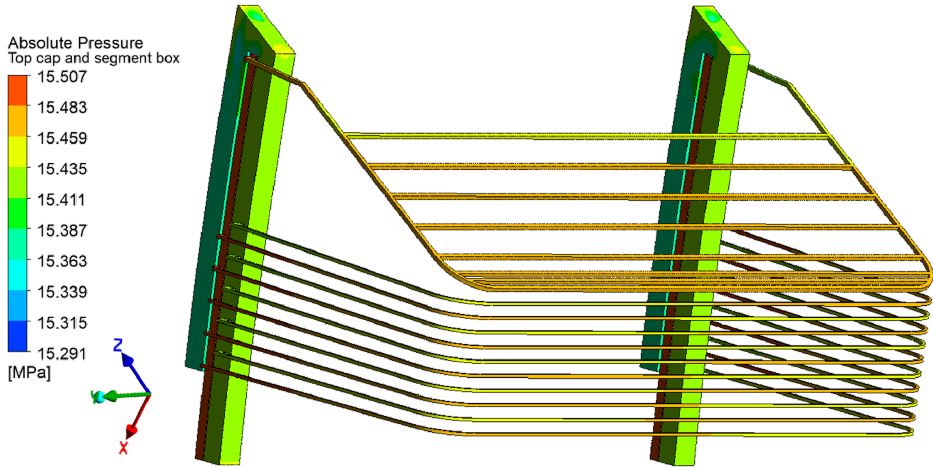
Figure 9. Absolute pressure distribution in the SB cooling